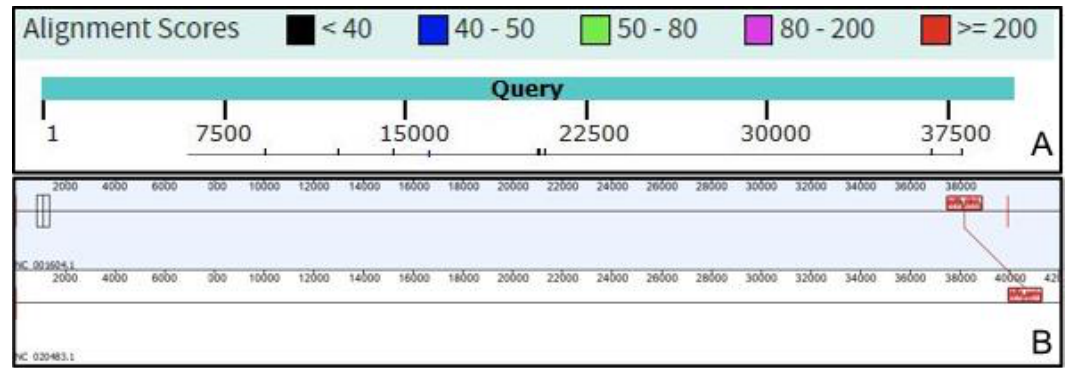
Figure 3. Genome alignments of the Escherichia coli T7 phage (NC_001604.1) and Pelagibacter phage HTVC011P (NC_020483.1) using ( A ) NCBI BLASTN, with the T7 genome as query; and ( B ) progressiveMAUVE plugin from Geneious software [26].